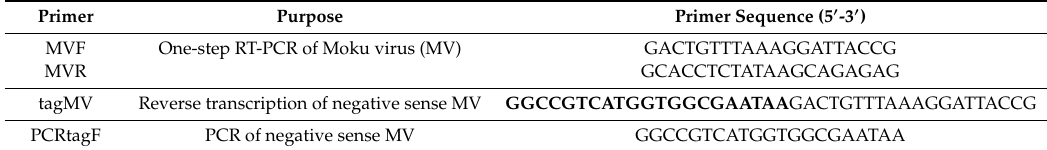
Table 1. Primers used in this study. Bold nucleotides indicate the tag